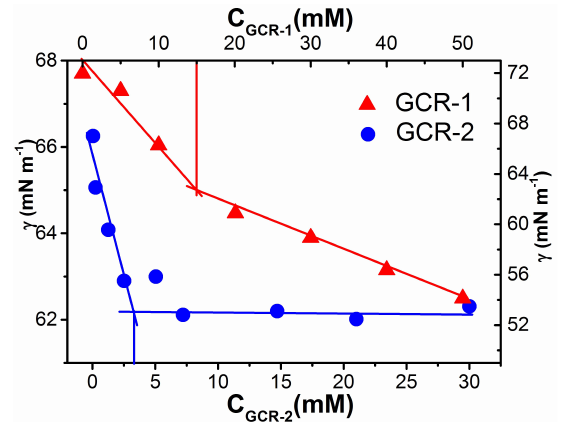
Figure 2. Isotherm of surface tension (γ) of calix[4]resorcinarenes solutions, 25 °C: 1 - water solution of GCR-1; 2 - water solutions of GCR-2 in the presence of two-fold excess of MG.